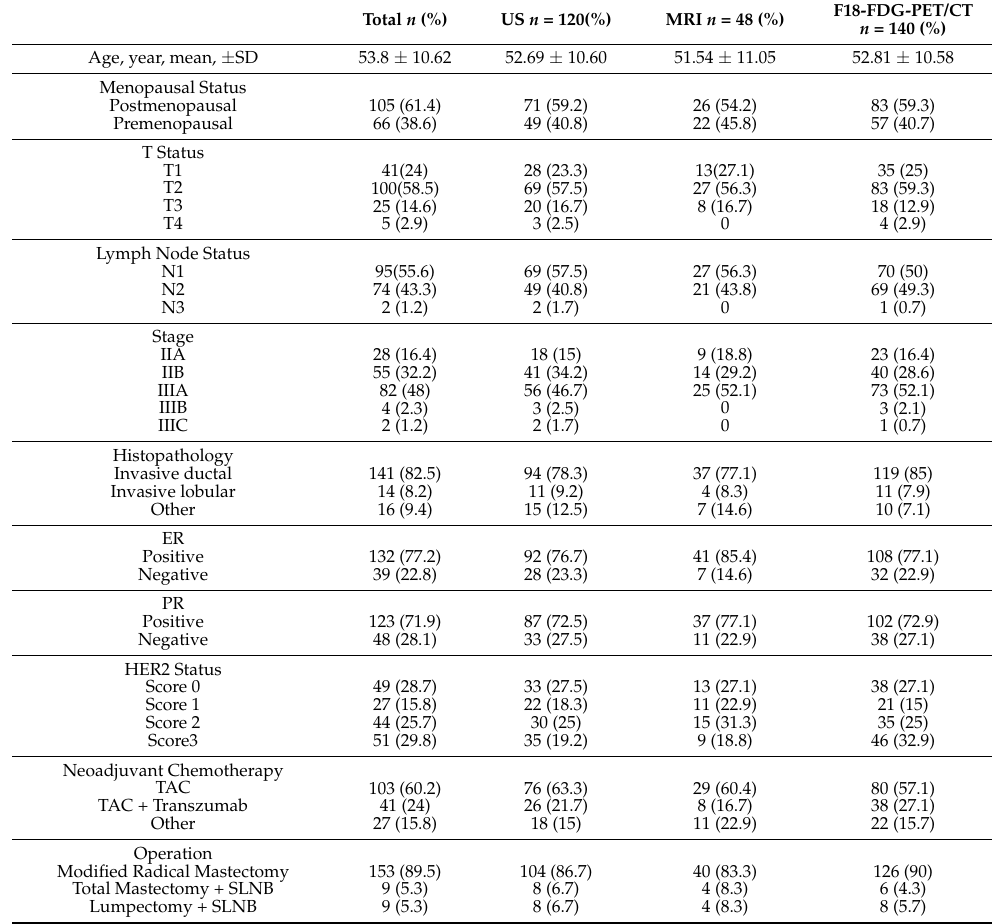
Table 1. Patient